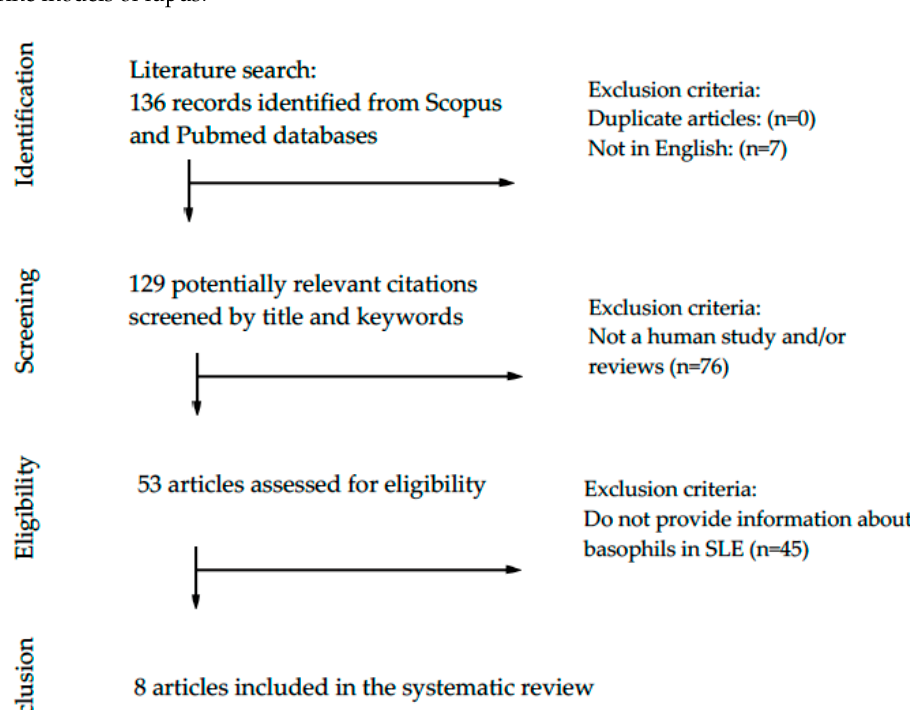
Figure 2. PRISMA flow diagram of the systematic literature search of studies investigating basophils in patients with systemic lupus erythematosus (SLE).